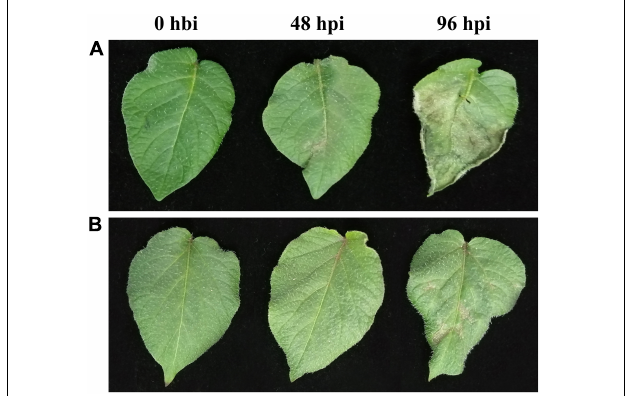
FIGURE 1 | Phenotypic changes of potato leaves at different time points of Phytophthora infestans infection. Virus-free seedlings of Favorita (A) and Ziyun No.1 (B) inoculated with P. infestans isolate SCPZ16-3-1 at 0 h before infection (hbi), 48 h postinoculation (hpi), and 96